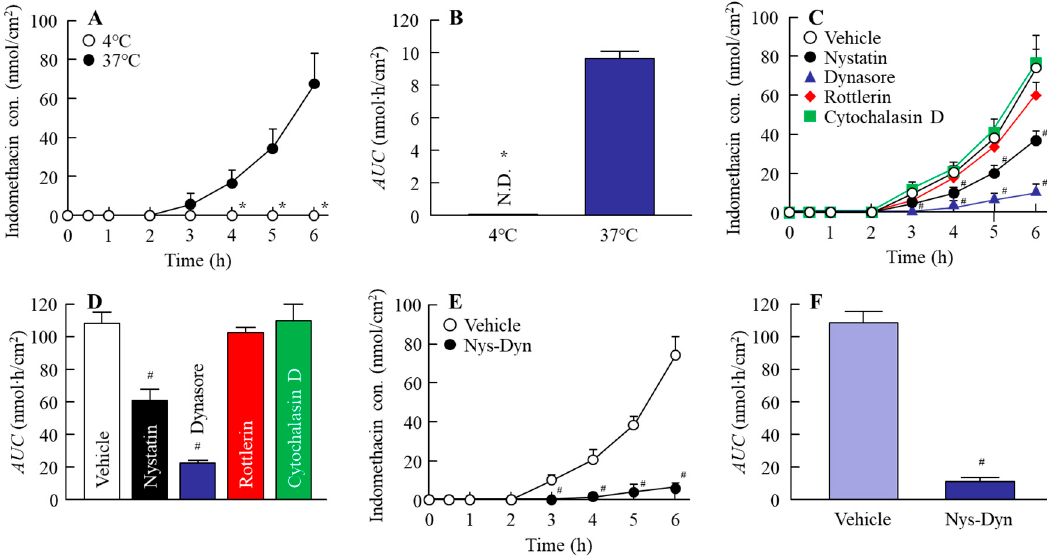
Figure 6. Endocytosis enhances the penetration of indomethacin nanoparticles in the ileum. A and B : Changes in penetration profile ( A ) and AUC ( B ) of indomethacin nanoparticles in the ileum under 4 ◦ C or 37 ◦ C conditions. C – F : Changes in the penetration profile ( C , E ) and AUC ( D , F ) of indomethacin nanoparticles in ileum treated with endocytosis inhibitors. Nys-Dyn indicates co-treatment with nystatin and dynasore. n = 5–8. * P < 0.05 vs. 37 ◦ C conditions. # P < 0.05 vs. vehicle for each category. Both of nystatin and dynasore significantly attenuated the penetration of indomethacin nanoparticles in the ileum. Table 2. Pharmacokinetic parameters for IND-NPs penetration in the ileum treated under cold (4 °C) temperature conditions or with endocytosis inhibitors.